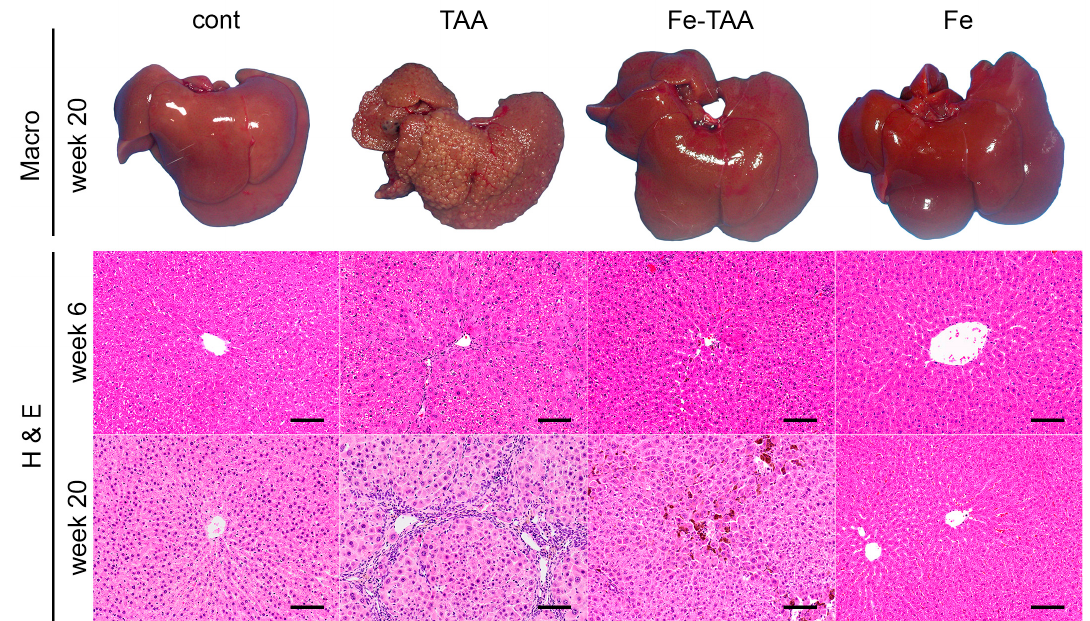
Figure 2. Macroscopic ( upper ) and hematoxylin and eosin (H & E; middle and lower ) images of the liver at weeks 6 and 20. Bar: 100 µm.